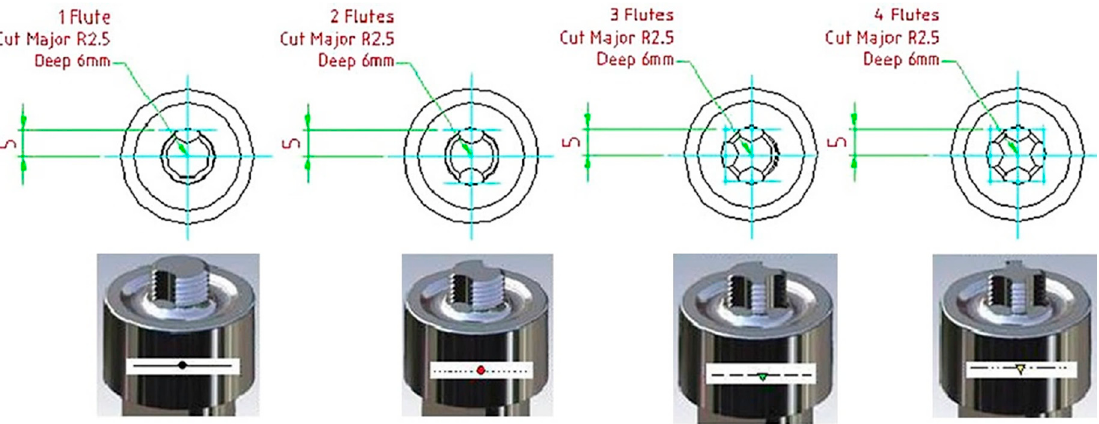
Figure 14. Examples of 1-flute, 2-flute, 3-flute, and 4-flute FSW tool design [150]. Reprinted from: Characterization of the influences of FSW tool geometry on welding forces and weld tensile strength using an instrumented tool. Journal of materials processing technology 203, no. 1–3 (2008): 46–57, Hattingh, D. G., C. Blignault, T. I. Van Niekerk, and M. N. James, Copyright 2008, with permission from Elsevier.